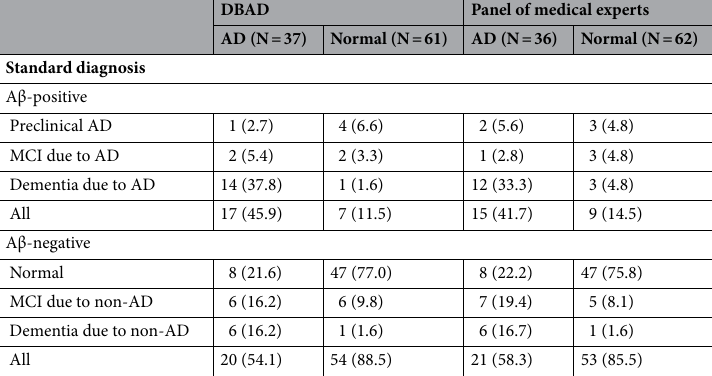
DBAD Panel of medical